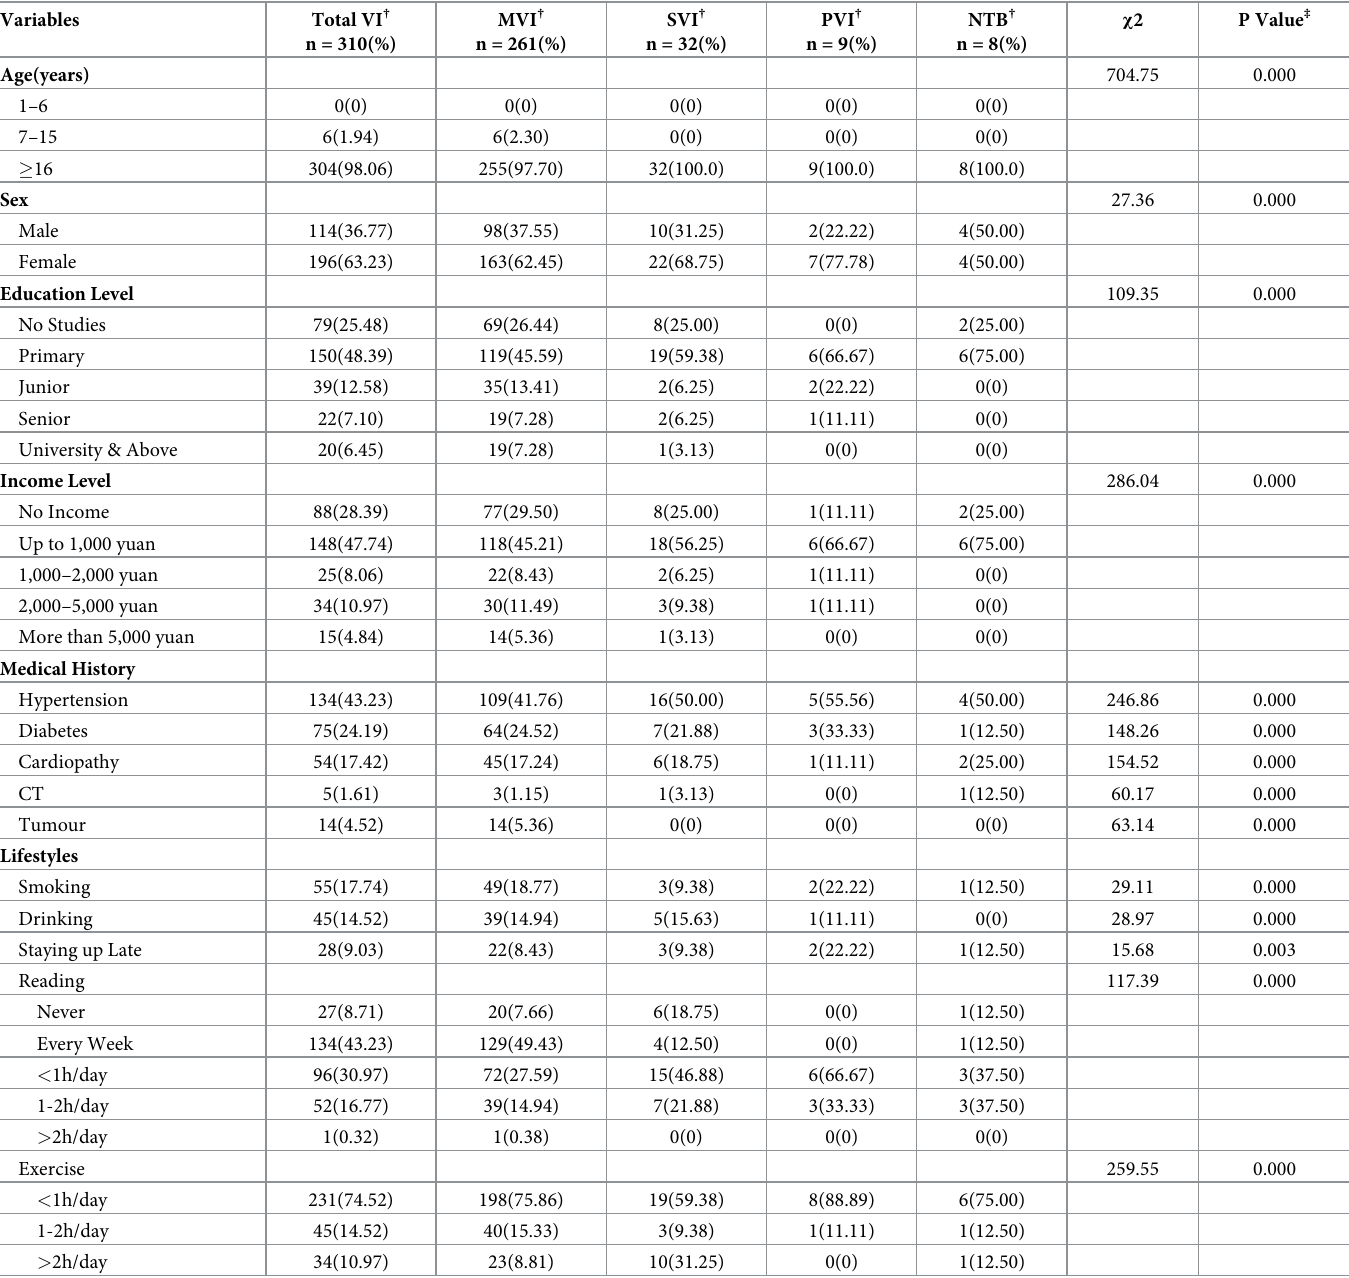
Table 3. Distribution of demographic, socio-economic status, medical history and lifestyle variables stratified by the severity of visual impairment.